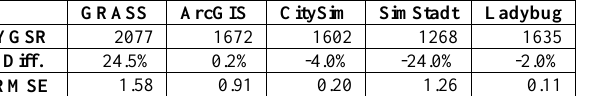
Figure 7. Yearly time series of daily global solar irradiation resulting from the 5 simulation tools and compared to the meteorological station (INMET, in black).